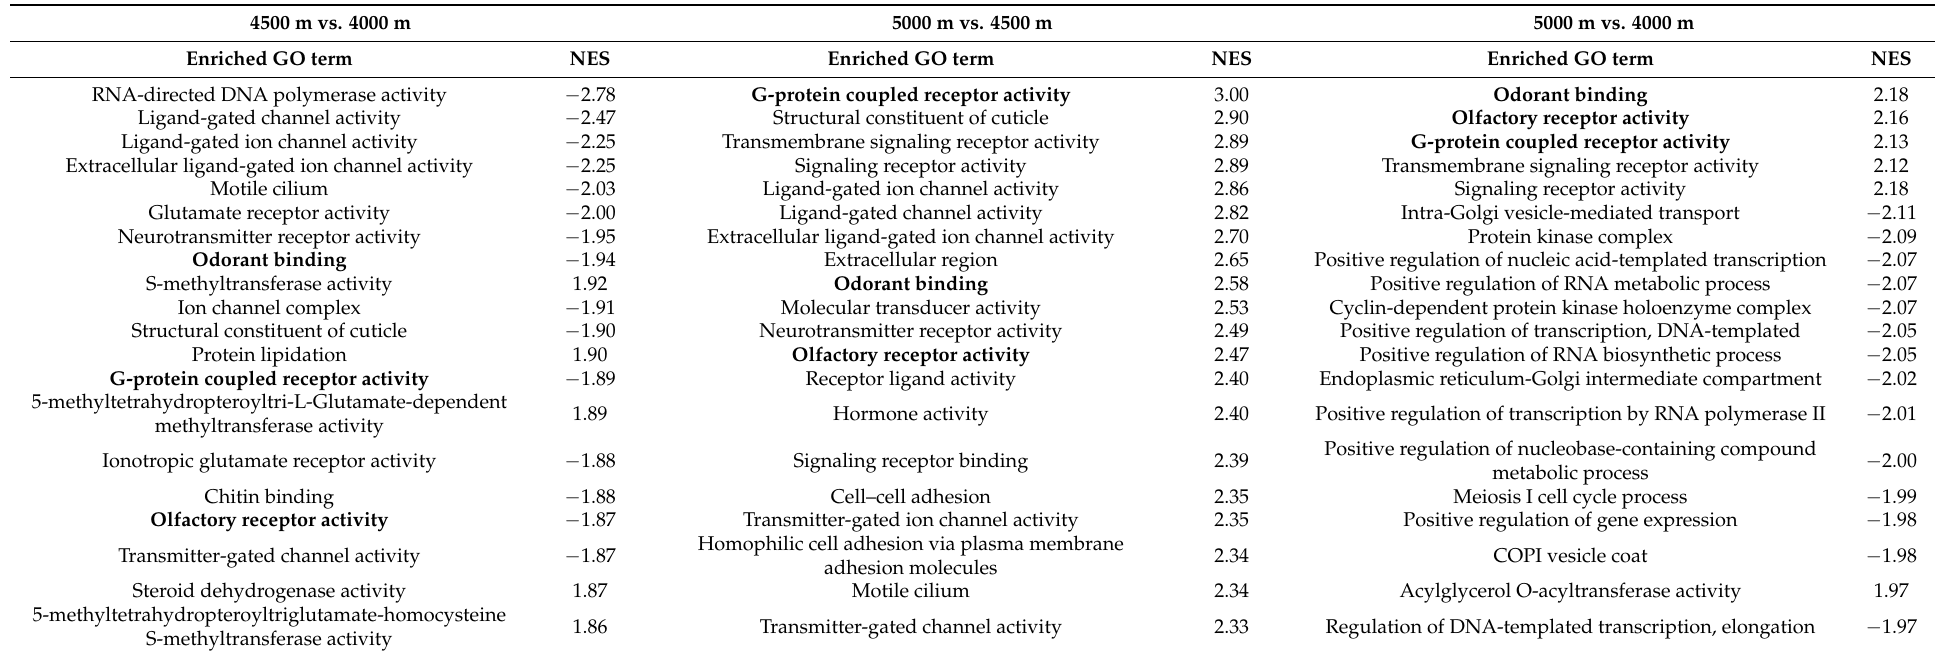
Table 2. Results of the gene set enrichment analysis for Bombus kashmirensis